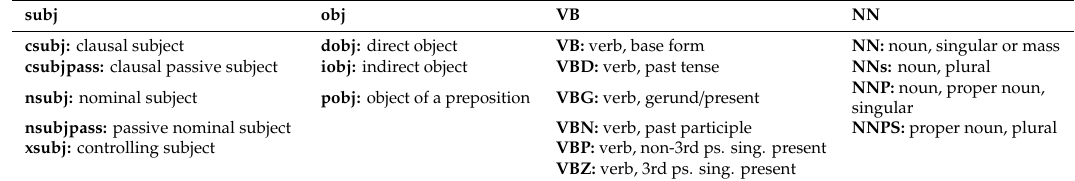
Table 2. All the dependency relation including subj and obj, parts of speech including VB (verb) and NN (noun) defined by Standford Parser and what they stand for.